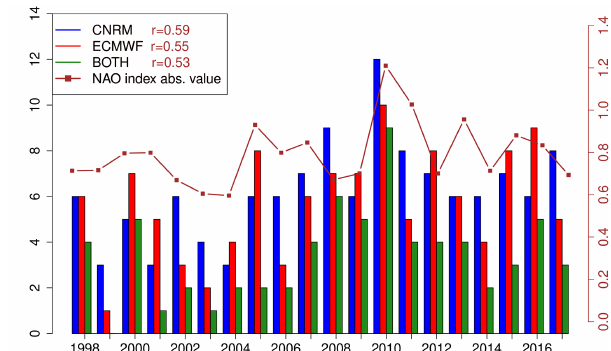
Figure 4. Yearly number of skillful forecasts for CNRM (blue), ECMWF (red) and both systems (green) computed on EUR week 3 temperature forecasts. The broken brown line shows the absolute value of the winter NAO index derived from ERA5 (see text). The “ r ” values reported in the legend correspond to the correlation of this index with the yearly number of skillful